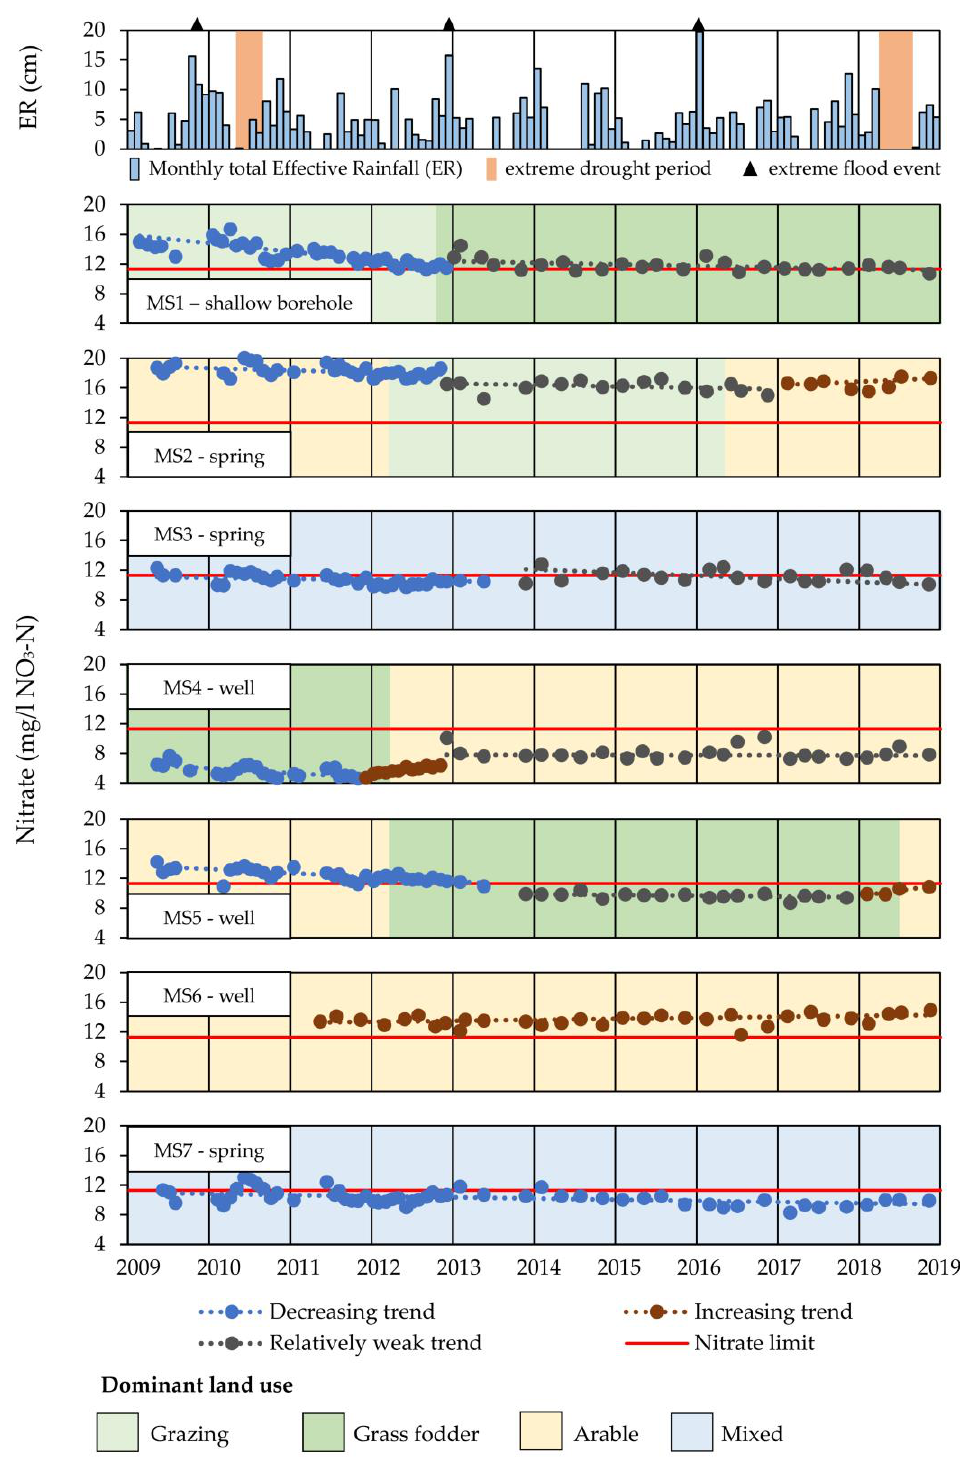
Figure 5. Time series of monthly total effective rainfall with annotated extreme weather events (top) and groundwater nitrate observations within the SEPA Ythan groundwater quality Monitoring Stations (MS 1–7) (SEPA) annotated with identified sub-trends and interpretations of land use (bottom). Major vertical gridlines indicate the first day of the year.